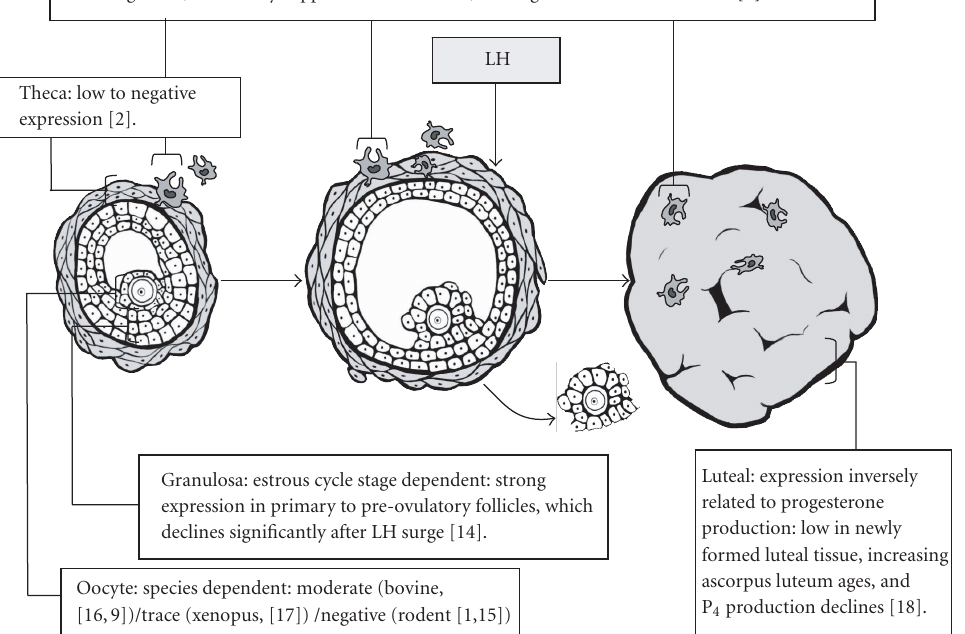
Figure 1: Overview of PPARG expression by specific ovarian cell types, as follicular development progresses from early antral and preovu- latory follicle to postovulatory corpus